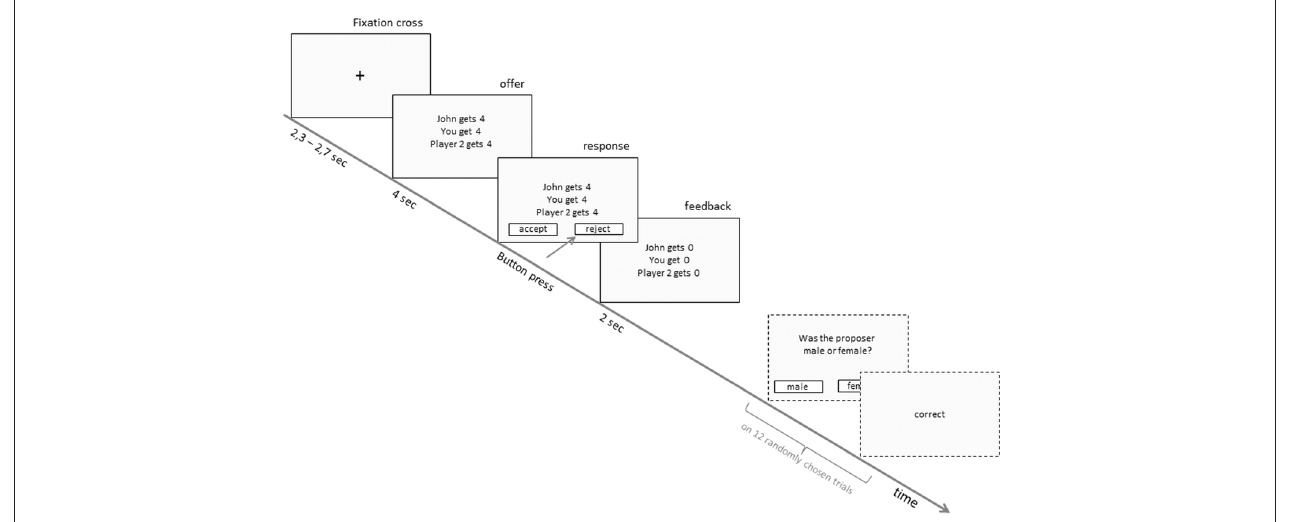
FIGURE 1 | Single-trial setting. Trials started with a fixation cross with a variable time interval, followed by the presentation of the offer. After the duration of 4s two boxes appeared at the bottom of the screen indicating